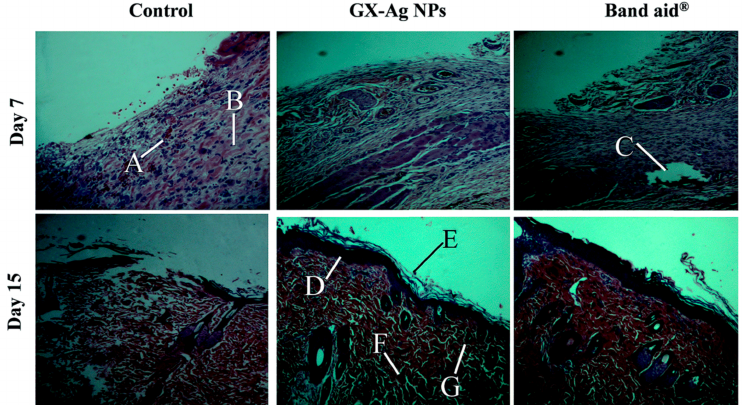
Figure 6. Histological examination in wound healing of glucuronoxylan-mediated AgNPs on Day 7, and 15 by Hematoxylin & eosin (H&E) staining: ( A ) neutrophils accumulation; ( B ) collagen deposition; ( C ) hair follicle; ( D ) epidermis; ( E ) stratum corneum; ( F ) dermis; and ( G ) fibroblasts. Reproduced with permission